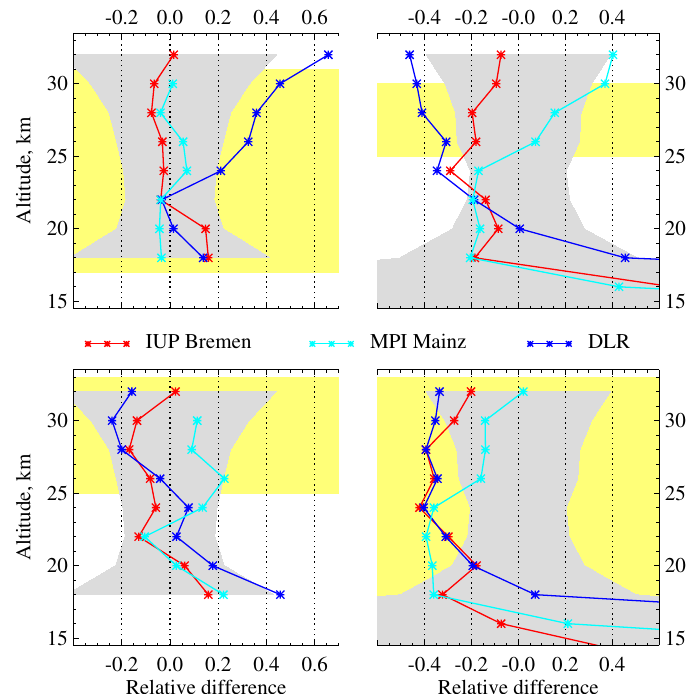
Fig. 24. Same as in Fig. 23 but for relative differences with respect to balloon-borne DOAS results, e.g., IUP Bremen/DOAS-1, etc.